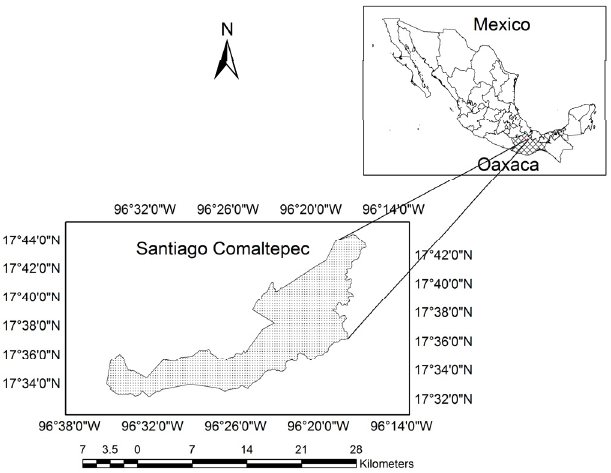
Figure 1. Location of the study area.